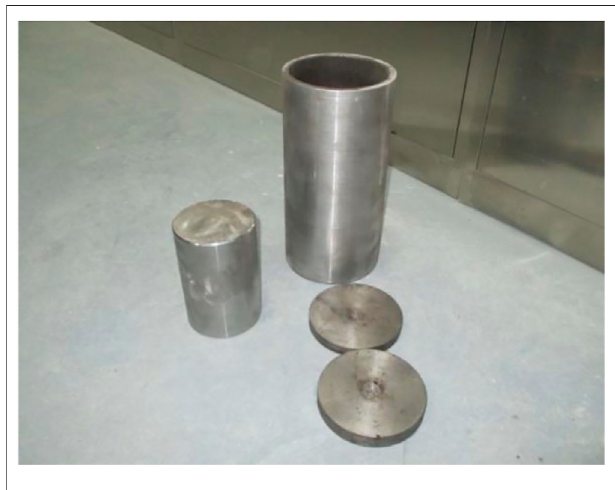
FIGURE 3 | Compaction